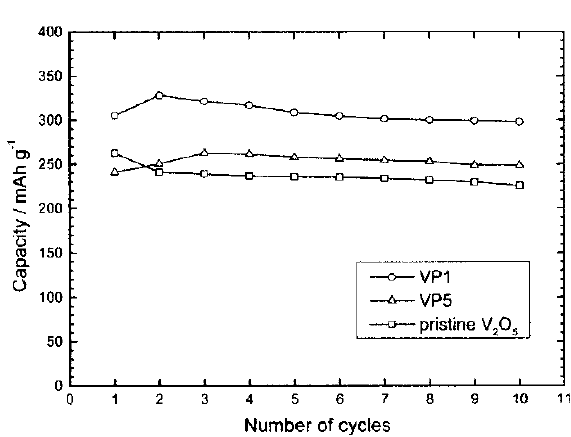
FIGURE 8 Evolution of discharge capacity with the number of cycles for pristine V 2 O 5 , VP1 and VP5. The data were obtained at a current density of 15mA = g. The potential range was set to 2.0–4.2V vs. Li for V 2 O 5 , and to